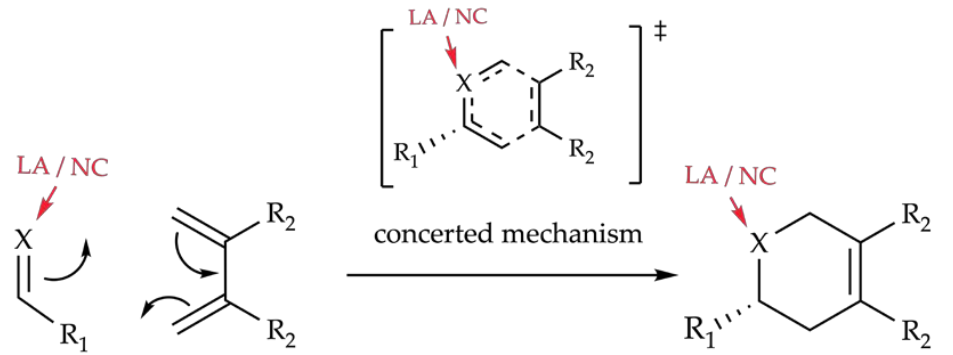
Scheme 1. Schematic representation for the endo hetero-Diels–Alder reaction between a catalyzed dienophile and a diene. LA denotes Lewis acid, NC is for non-covalent interaction donor, ‡ indicates the transition state.